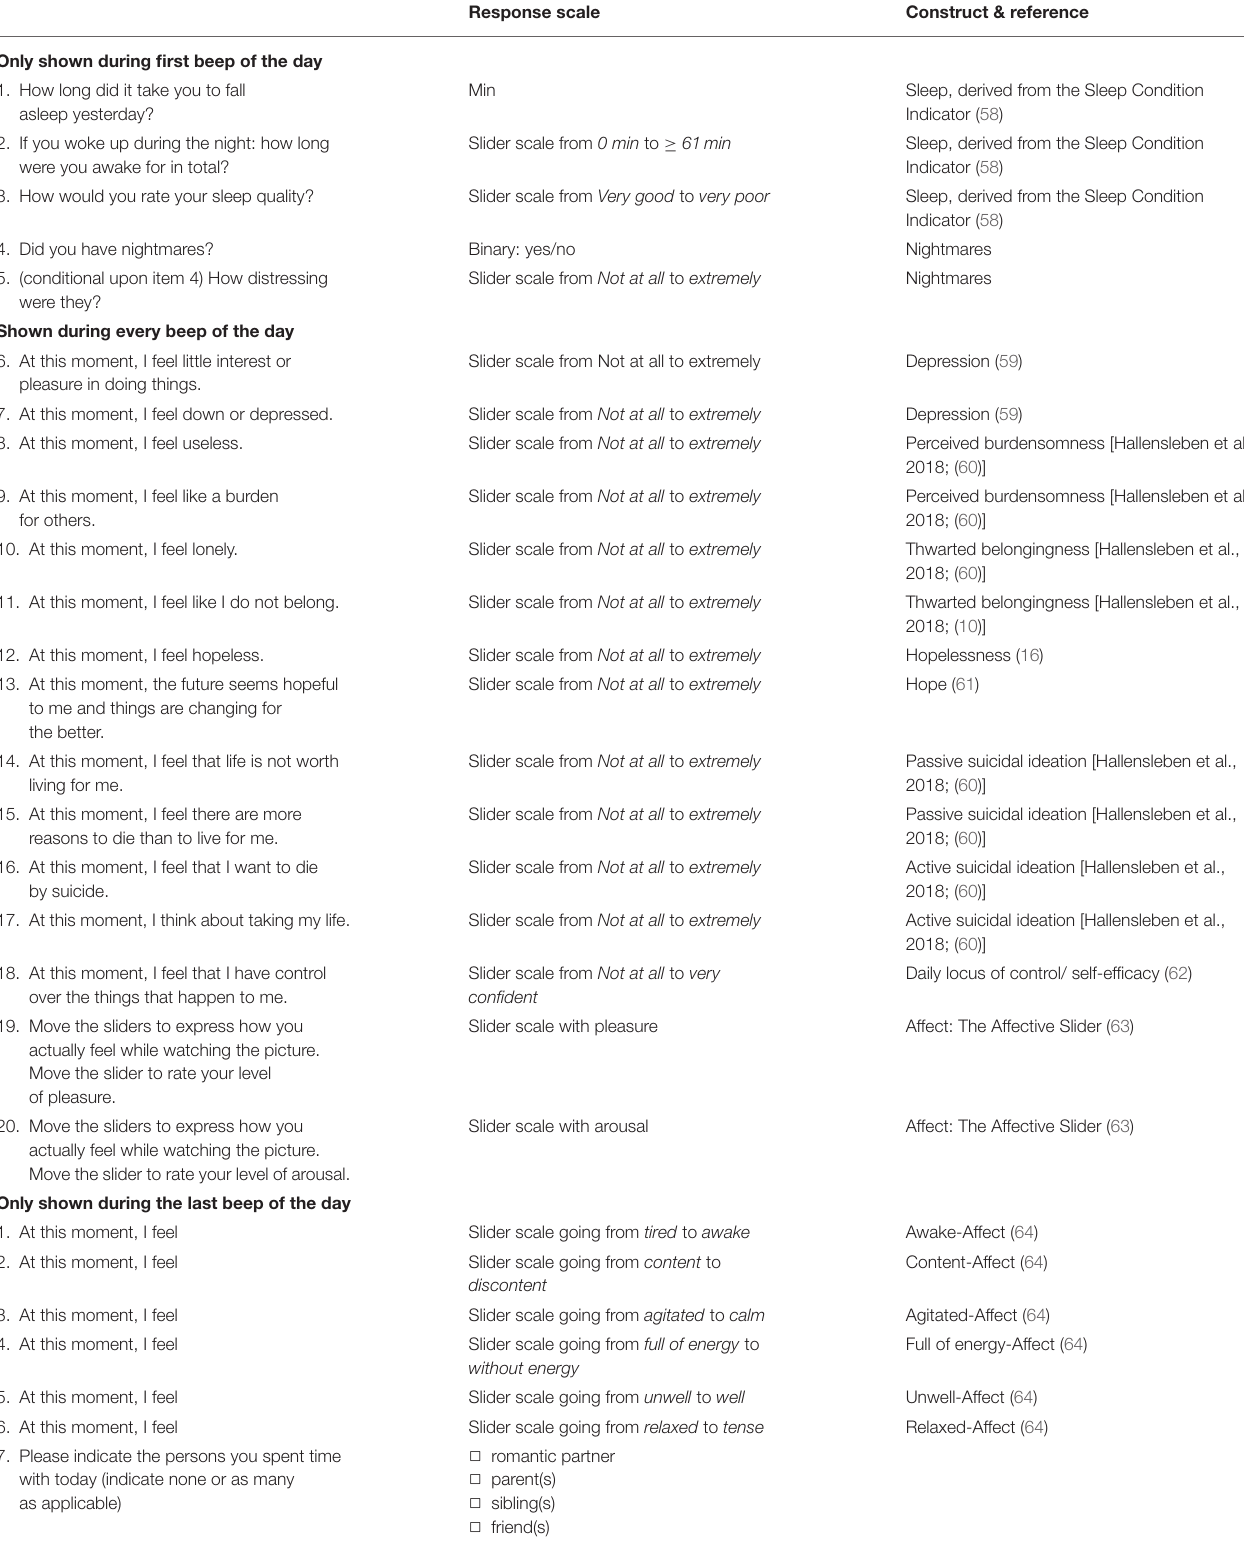
TABLE 2 | Self-report items of the ecological momentary assessment administered through